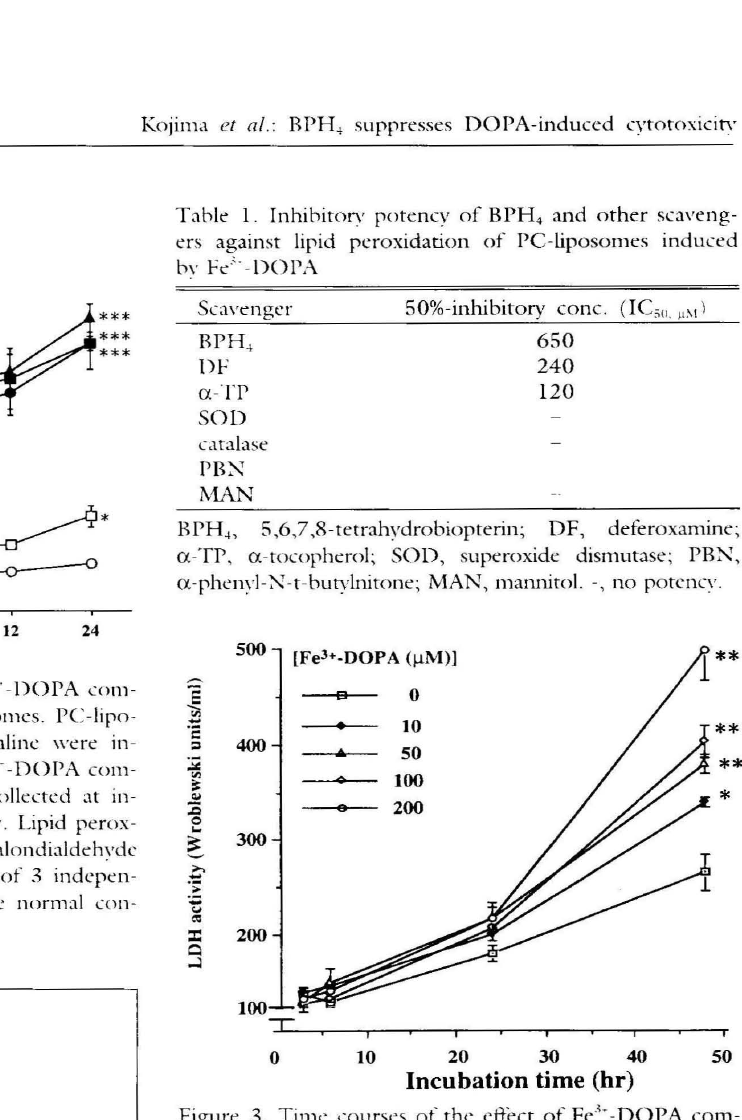
Figure 3 Time cnurses nf the efreer of Fe'--DOPA com plex on LDH relnse h\· PC-12 cells 3S a mark of cell damage. The cells were incuhated with 10, 50, 100, and 200 p'\l fe " ,DOPA complex f(lr 48 hr. f\liquots of the medium were collected at interl'als and subjected to LDH ass;1\'. LDH actj\'ity is represented as vVroblewski units/ ml medium. Each value is the mean ± S.E.M. of 4 independent assavs. Significantll' difrerent 6'om the nor mal control (0 pM): *P<0.05, ***P< 0.01 .